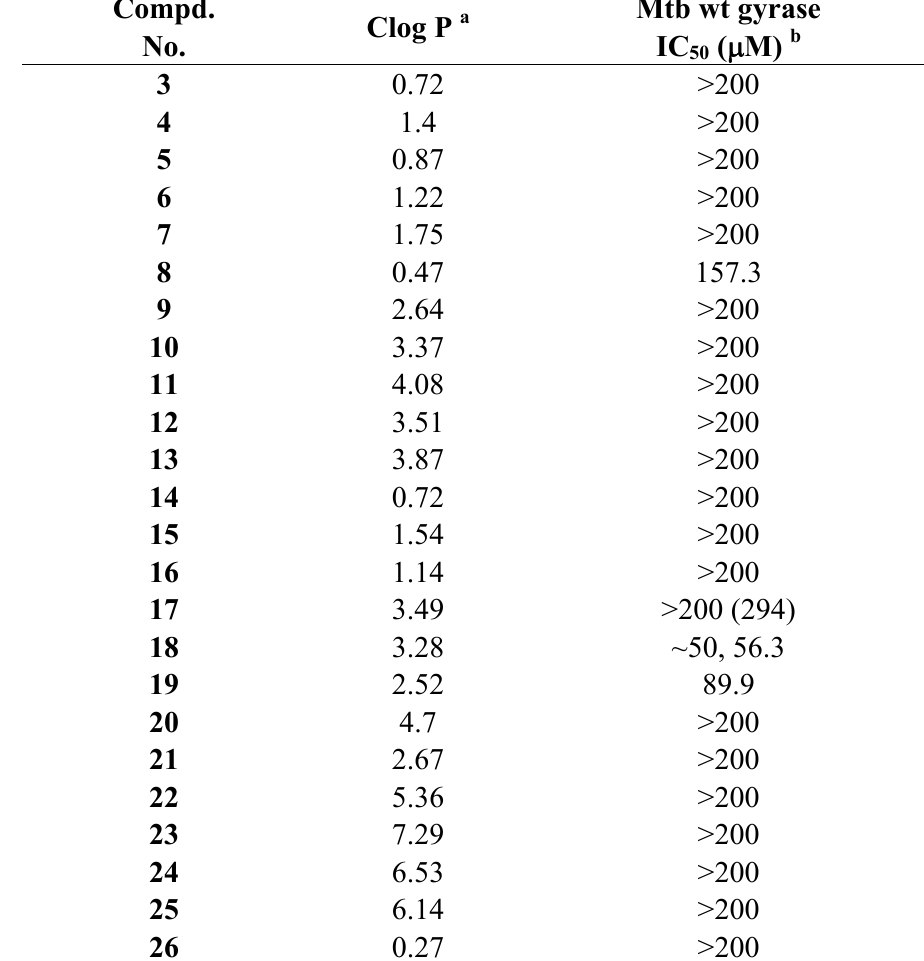
Table 1. Lipophilicity (Clog P) and Mtb wt gyrase inhibitory activity of the synthesized Schiff bases of